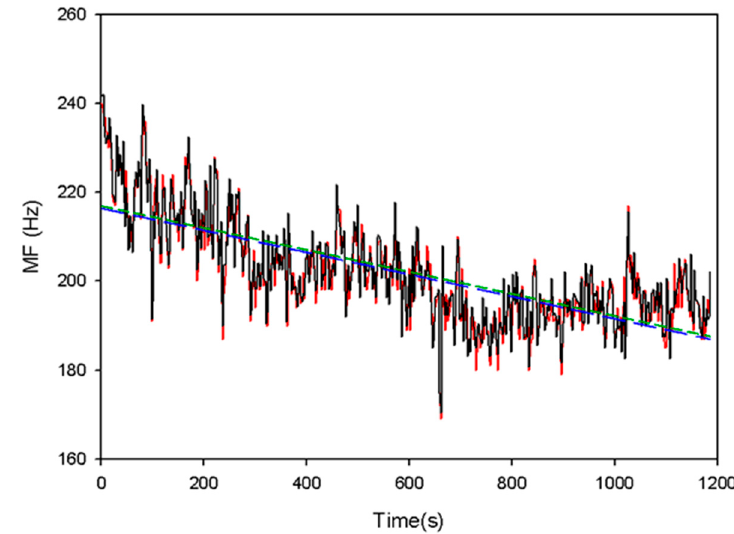
Figure 10. The real-time MF values on the EMG patch (red solid line) and the off-line MF values on the computer system (black dotted line). The slopes of their linear regression are − 0.0248 Hz/s and − 0.0247 Hz/s for the real-time MF values (short dash line) and off-line MF values (long dash line).